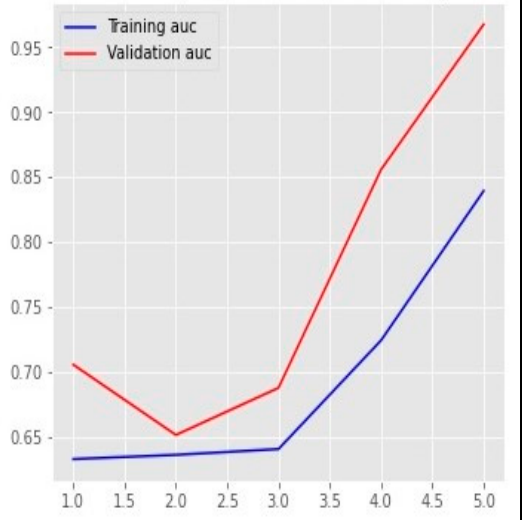
Figure 14. The training and validation AUC of the proposed Bi-LSTM model.